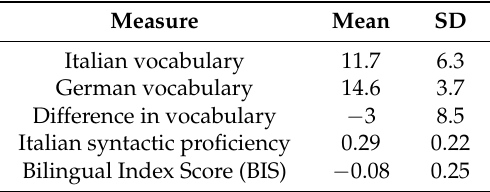
Table 2. Descriptive statistics for Italian and German vocabulary, their difference, syntactic proficiency and BIS. The values related to vocabulary scores are reported in raw